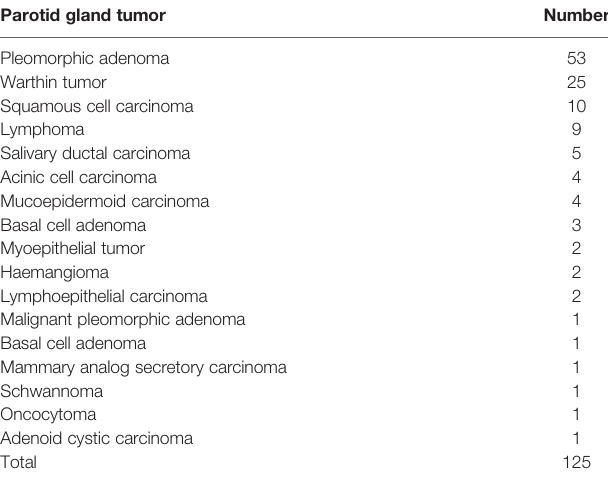
TABLE 1 | Details of the parotid